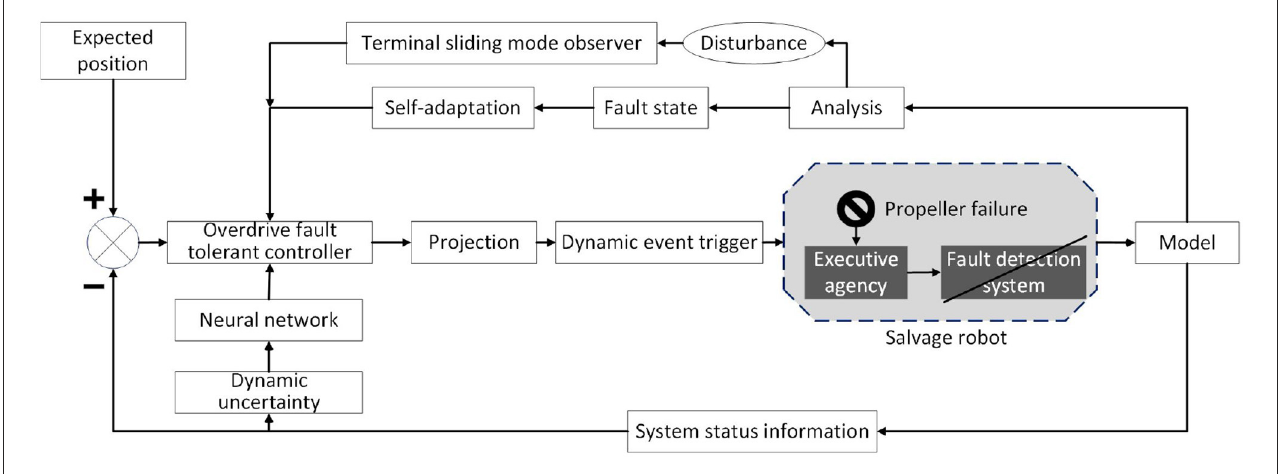
FIGURE2 Schematic diagram of a fault-tolerant control scheme for proportional logarithmic projection analysis of